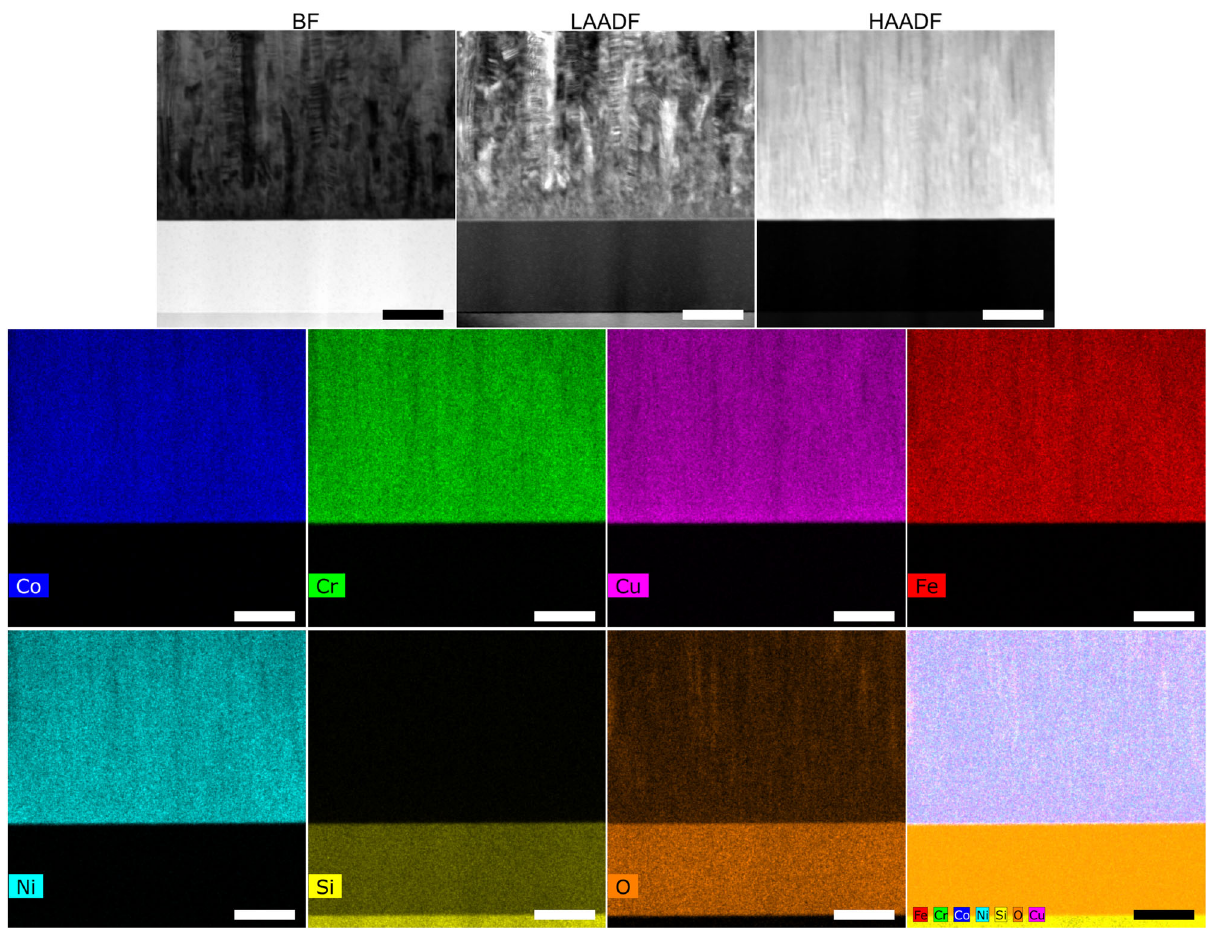
Fig. 2 As-grown HEA fi lm on SiO 2 /Si is in solid-solution. STEM-BF, LAADF, and HAADF images and EDS maps of the as-grown CoCrCuFeNi fi lm on a SiO 2 substrate. The scale bar length in all images is 70 nm.